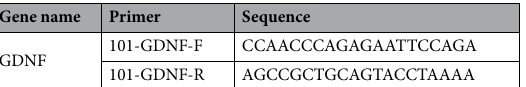
Table 1. The primers for qPCR. Note: qRT-PCR: quantitative real-time polymerase chain reaction; GDNF: glial cell line-derived neurotrophic